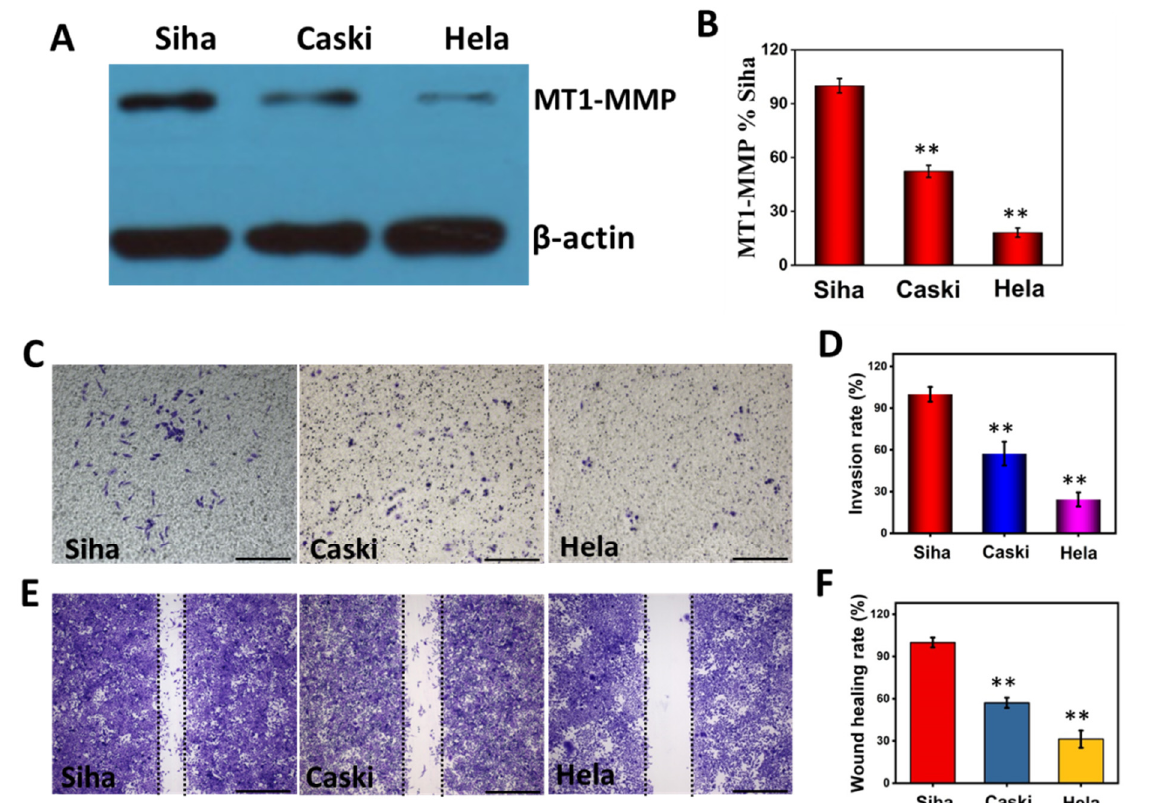
Figure 3. ( A,B ) The expression level and analysis of MT1-MMP in Siha, Caski and Hela cells. ( C,D ) Photo images and analysis of invasion ability of Siha, Caski and Hela cells after 24 h incubation. ( E,F ) Photo images and analysis of migration ability of Siha, Caski and Hela cells after 24 h incubation. Scale bars, 200 μ m. ** p < 0.01.